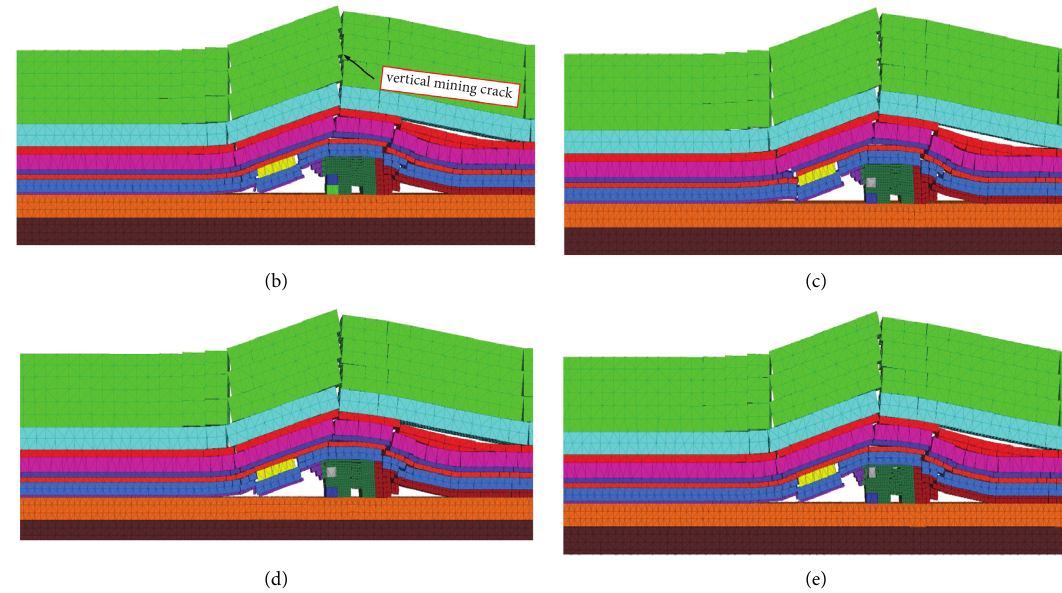
Figure 11: Overlying rock movement caused by recovery at the 30503 working face and its influence on new roadway 2 (after new roadway 1 has been filled). (a) H �− 2 m. (b) H � 0m. (c) H � 2m. (d) H � 4 m. (e) H �